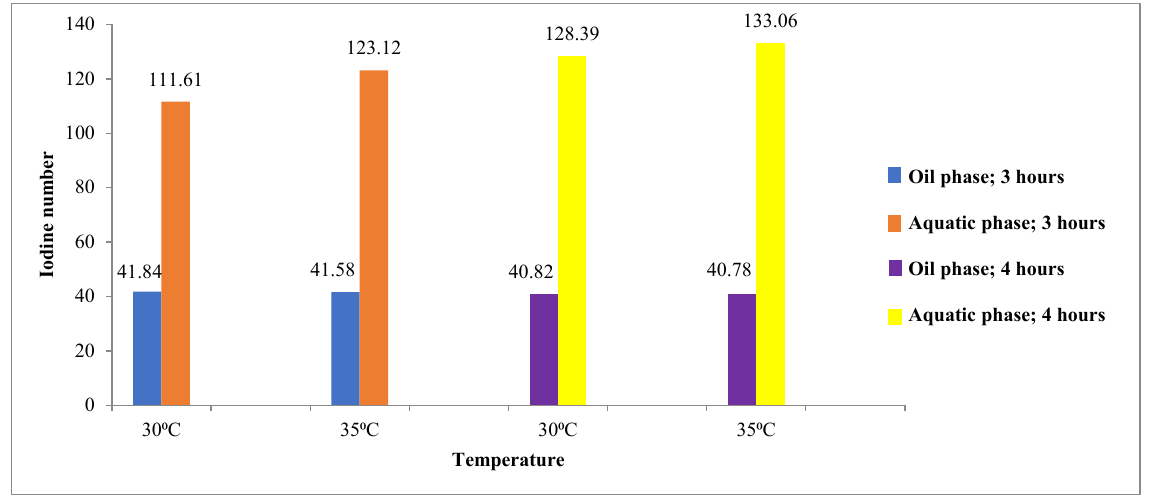
Figure 5. Effect of temperature and time on the iodine number at a ratio of 1:3. Table 5. Oxidation stability results based on iodine